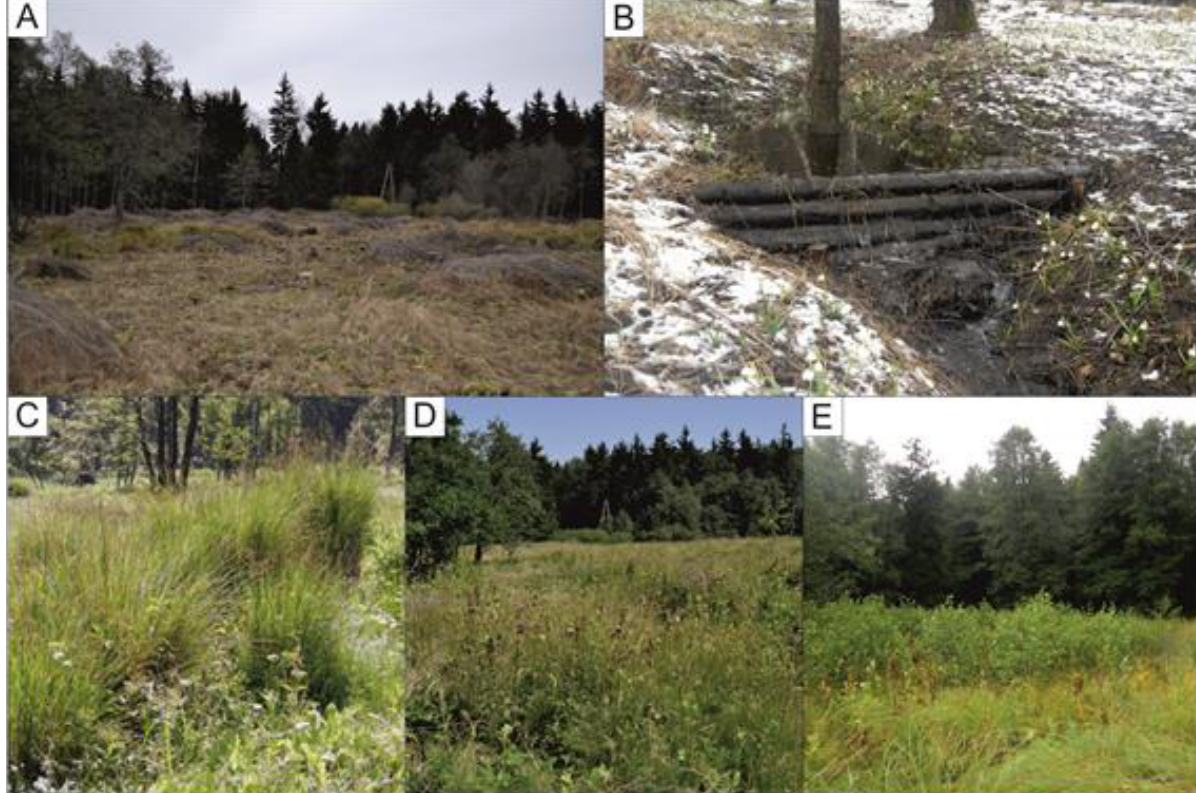
Figure 2. (A) Spruce branches, slash and trunks on the peatland surface (the effect of clearcutting trees) in September 2010. (B) Single-wall wooden dam in the drainage ditch, March 2011. (C) Regeneration of Carex paniculata within Plot 2, June 2013. (D) Veratrum lobelianum entering the fen, June 2014. (E) Young Alnus incana trees in the uppermost part of peatland (Plot 1), August